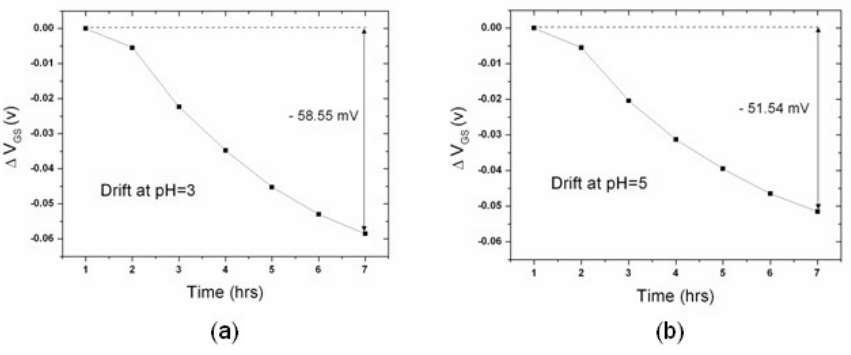
Figure 4. The drift of the n-channel ISFET over the first seven hours at (a) pH3 (b) pH5 (c) pH7 (d) pH9 (e) pH11. The drift over the first seven hours was (a) -58.55mV (b) - 51.54mV (c) -41.61mV (d) -34.64mV and (e) -32.52mV,